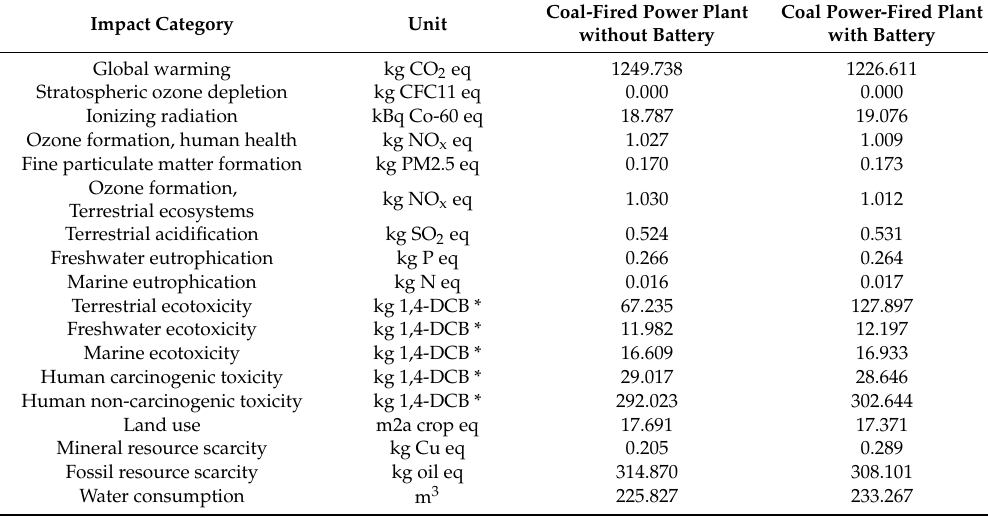
Table 3. Calculated environmental impact per 1 MWh of electricity (ReCiPe2016 Midpoint, H).